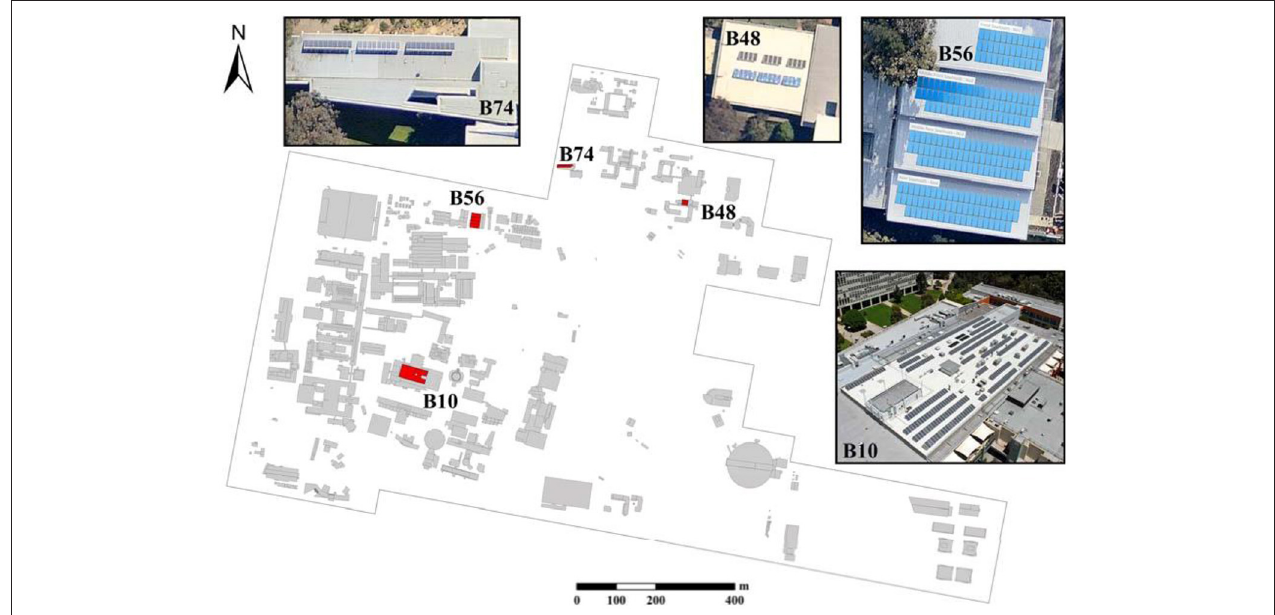
FIGURE 4 | Locations of existing solar PV systems in the study area.